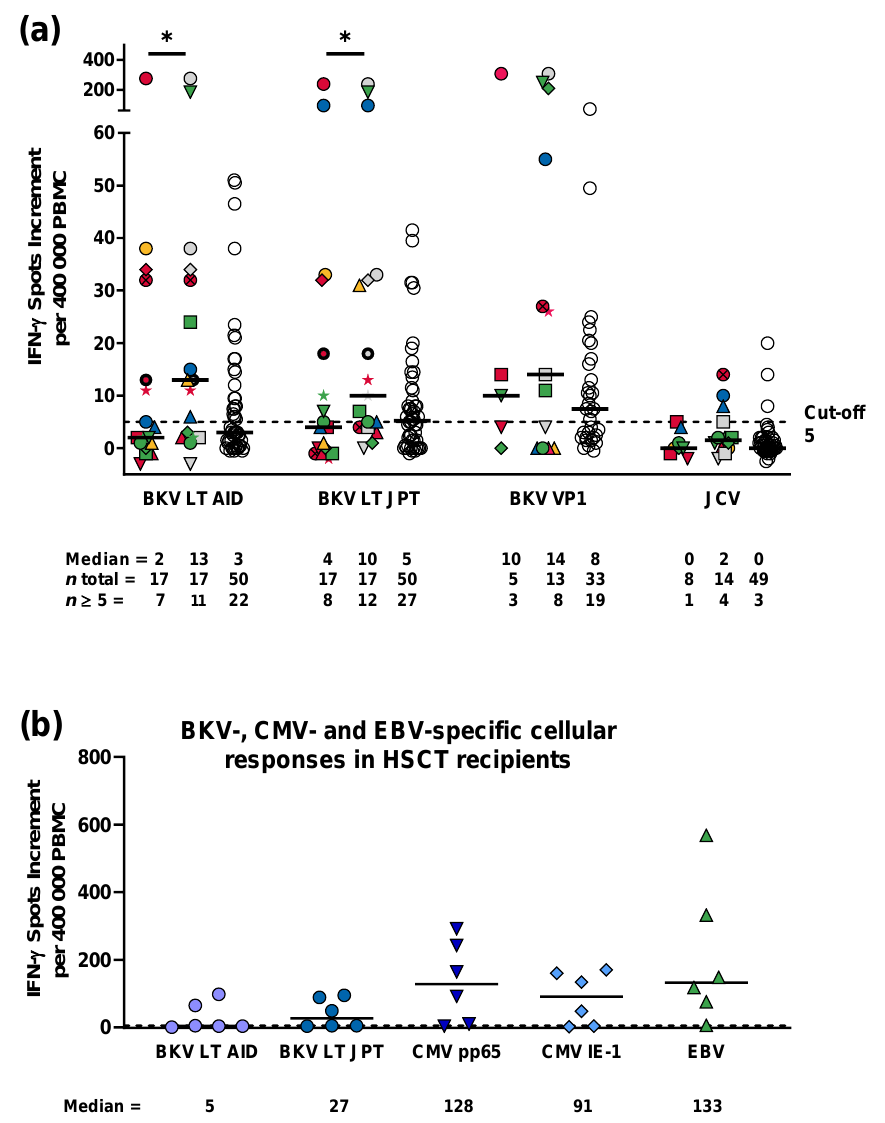
Figure 3. Specific cellular immunity against peptides of the BK virus (BKV). ( a ) Responses against large T (LT) and viral protein (VP) 1 peptides of BKV and against a structurally related polyomavirus, the JC virus (JCV), in 17 hematopoietic stem cell transplant (HSCT) recipients with BK virus-related cystitis (coloured symbols) and in 50 healthy controls (HC, white circles). The first dataset in each patient is shown as the left panel, with the maximum response as the middle panel. Each patient is depicted by an individual symbol. Treatment groups are colour-coded (yellow: with reduction of immunosuppression only, red: with cidofovir only, blue: with VSTs only, and green: with cidofovir and VSTs). For patients tested only once, the first set of data is equal to the maximum response, which is shown as a grey symbol (and which is not considered for comparison of the first and maximum response). Please note that only part of the datasets contained VP1 and JCV. One-day cell cultures were performed with 400,000 peripheral blood mononuclear cells and the antigen concentrations defined as optimal. ( b ) Specific cellular immunity against LT peptides of BKV, cytomegalovirus (CMV) phosphoprotein 65 (pp65), CMV immediate early-1 (IE-1), and Epstein–Barr virus (EBV), analyzed in parallel in six HSCT recipients with BKV-related cystitis. Each viral antigen is indicated by a specific symbol and color. Median values are indicated with solid horizontal lines. The dotted horizontal line indicates the cut-off for positive responses (five spots increment). * p < 0.05 (Wilcoxon matched pairs test). BKV LT AID — BKV large T peptides (from AID), BKV LT JPT — BKV large T peptides (from JPT), BKV VP1 — BKV viral protein 1 peptides.